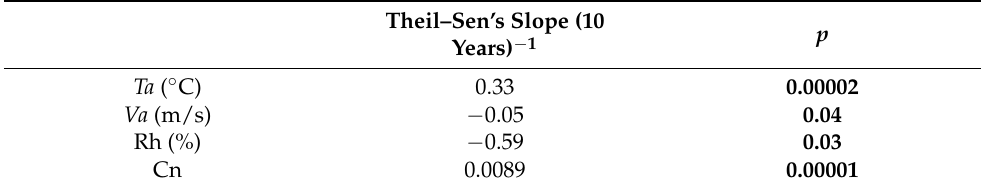
Table 3. Trends of air temperatures during the season of DJFM.